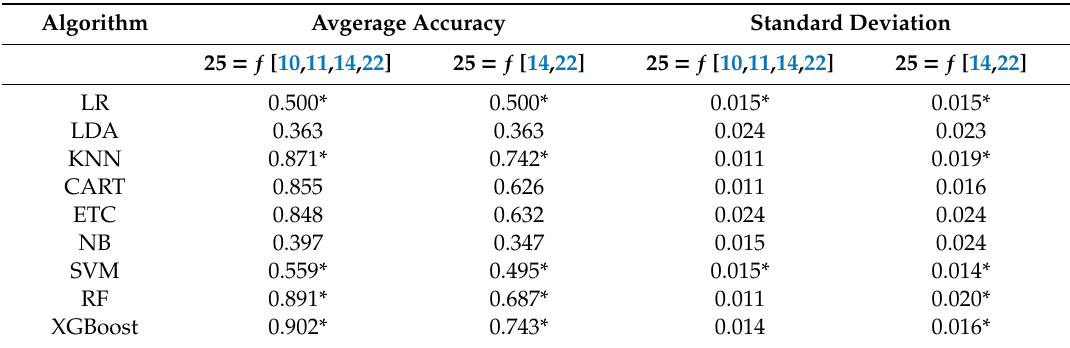
Table 9. Average accuracy—selected biometric data for plant configuration identification. With *: average accuracy defined considering the tuning of hyperparameters.